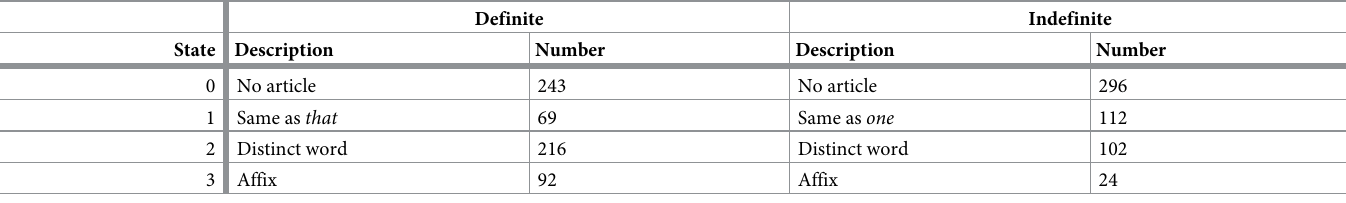
Table 1. Typological distribution of definite and indefinite